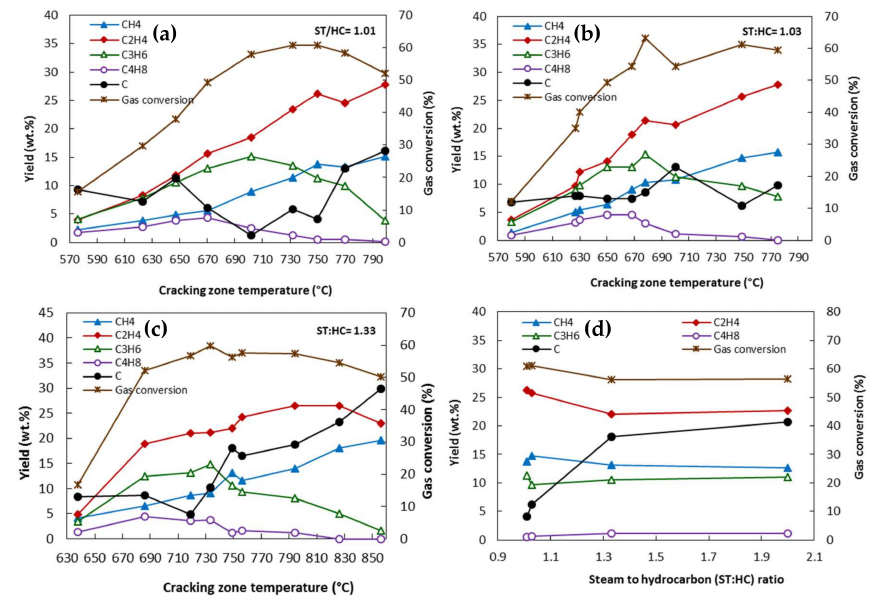
Figure 8. Effect of temperature at different steam-to-hydrocarbon (ST:HC) mass ratios ( a ) ST:HC = 1.01, ( b ) ST:HC = 1.03, ( c ) ST:HC = 1.33; and ( d ) the effect of ST:HC on the product yields of the thermal steam cracking of an atmospheric gas oil, reproduced from